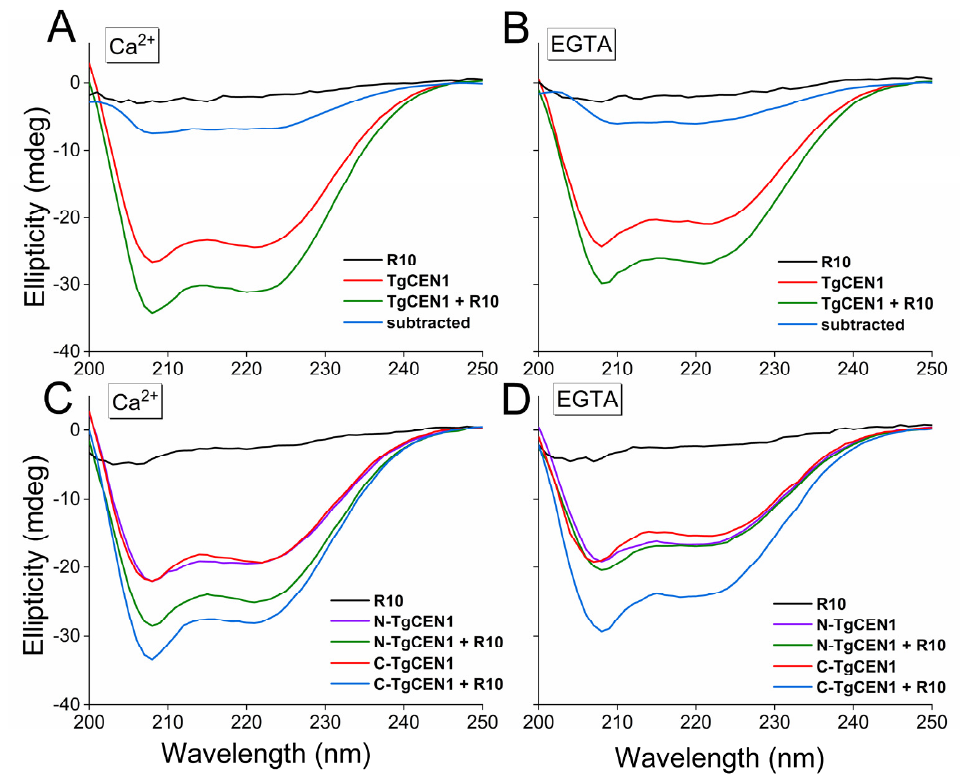
Figure 5. Far-UV CD analysis of R10 binding to intact TgCEN1 and its isolated domains in the presence of CaCl 2 or EGTA. ( A , B ) Far-UV CD spectra of R10 peptide alone (black line), TgCEN1 (red line), and protein–peptide complex (green line) in the presence of ( A ) 5 mM CaCl 2 or ( B ) EGTA. The CD spectrum resulting from subtraction of the spectrum of protein–peptide complex from that of protein alone was also shown (blue line). ( C , D ) Far-UV CD spectra of R10 peptide alone (black line), N-TgCEN1 (violet line), or C-TgCEN1 (red line), N-TgCEN1–peptide complex (green line) or C-TgCEN1–peptide complex (blue line) in the presence of ( C ) 5 mM CaCl 2 or ( D ) EGTA. In all spectra, the same concentration of TgCEN1 (0.2 mg/mL) was used, and a 1:2 molar ratio of R10 peptide was added. For the single domains, the same concentration of N-TgCEN1 or C-TgCEN1 (0.2 mg/mL) was used, and a 1:1 molar ratio of R10 peptide was added. Increasing the peptide-to-protein ratio was not accompanied by obvious CD changes, in perfect agreement with the ITC-obtained stoichiometry.